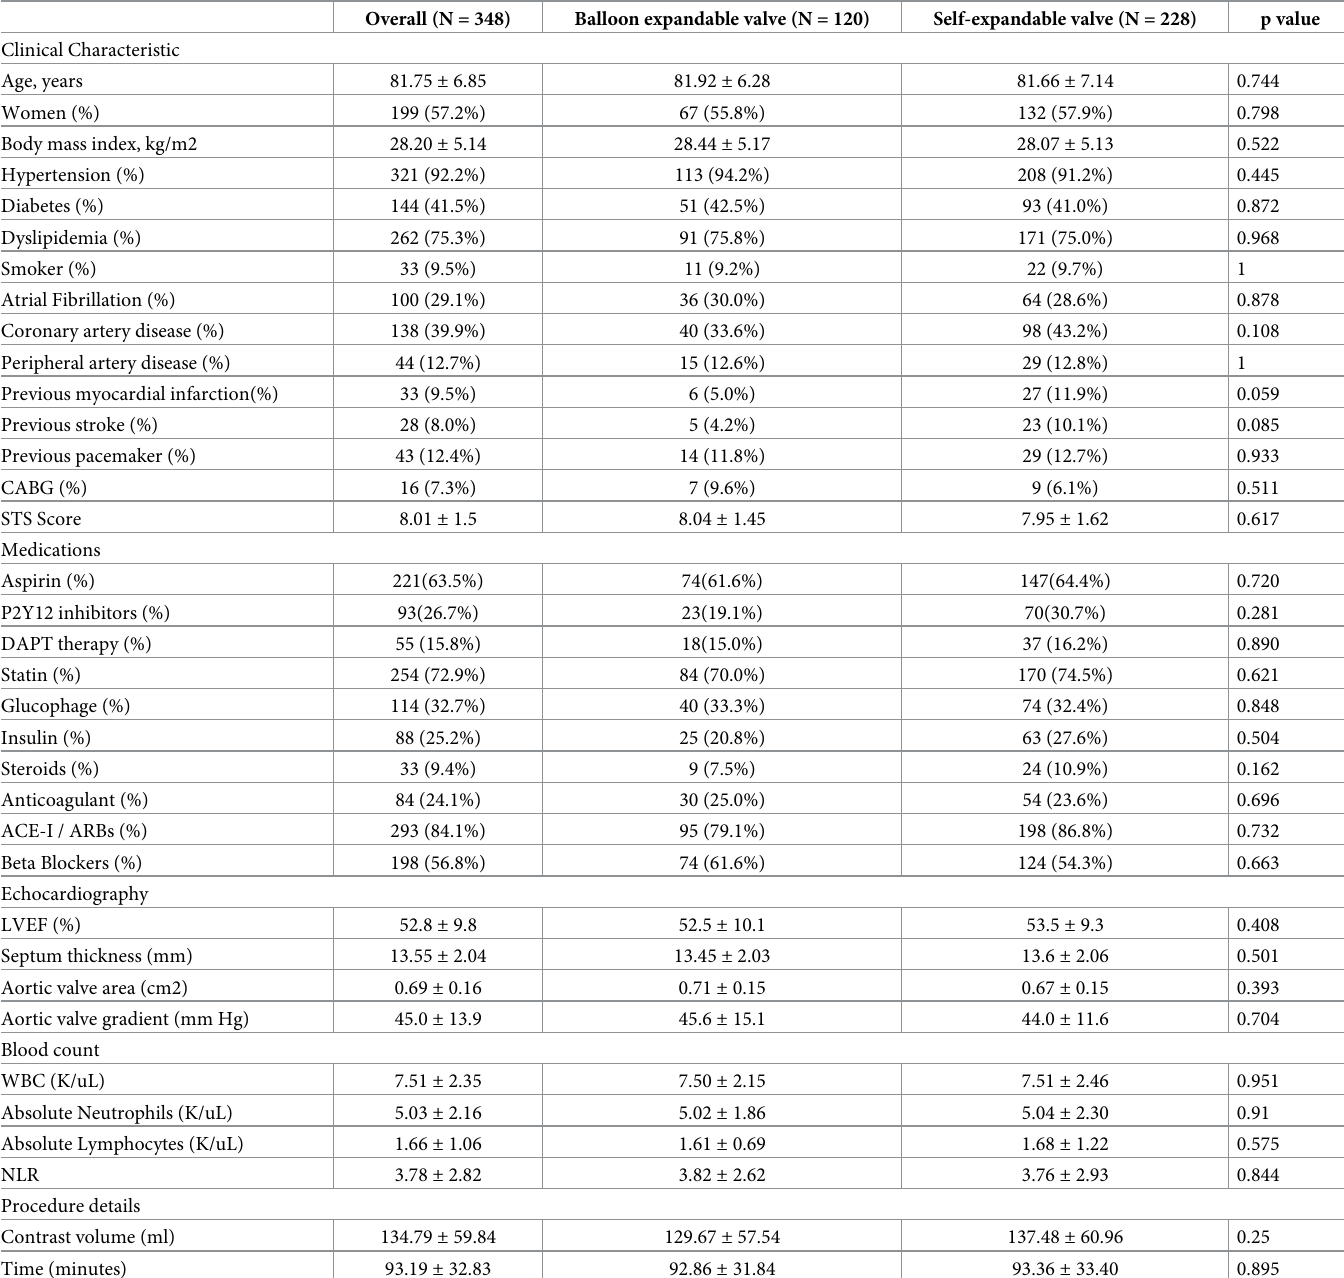
Table 1. Patients’ and procedural